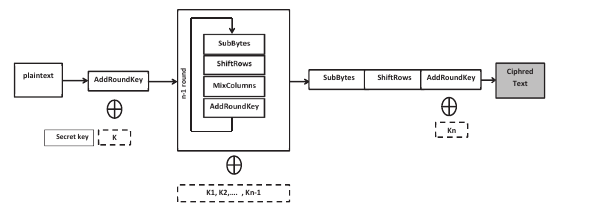
Fig. 1: Algorithm 1 : AES Encryption Algorithm